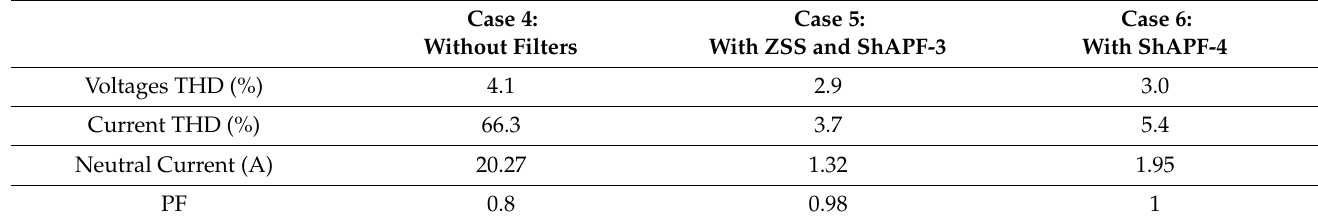
Table 7. Comparison of results for cases 4, 5, and